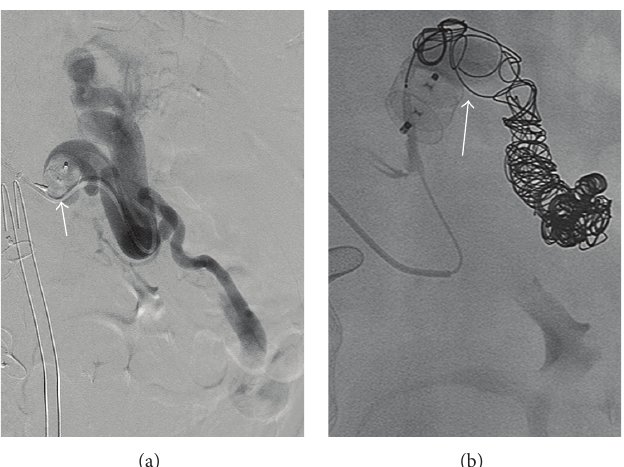
Figure 3: (a) Venogram after deployment of Amplatzer vascular plug (arrow) within splenorenal shunt. (b) Final image following placement of additional coils between initially placed coils and Amplatzer vascular plug.